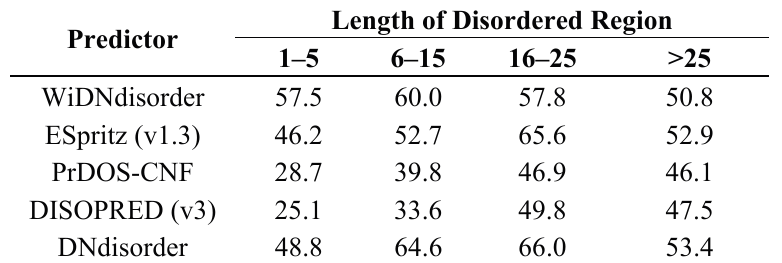
Table 5. Recall of disordered predictions by disorder region length on the CASP10